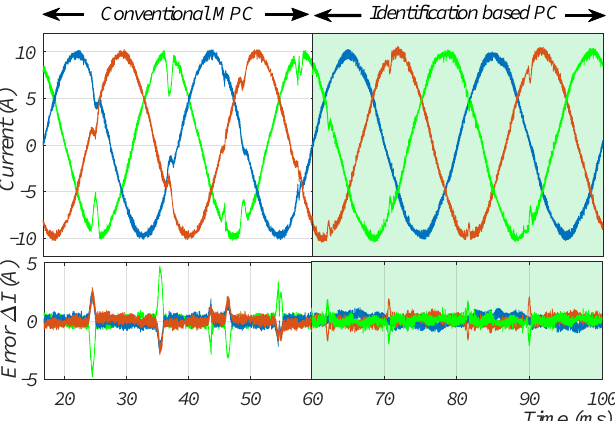
Figure 7. Impact of parameter mismatch on steady state output current of VSC: Double specified Figure 11. Performance comparison of conventional MPC and proposed resistive load ( R 2) and one half of filter inductance ( L ×